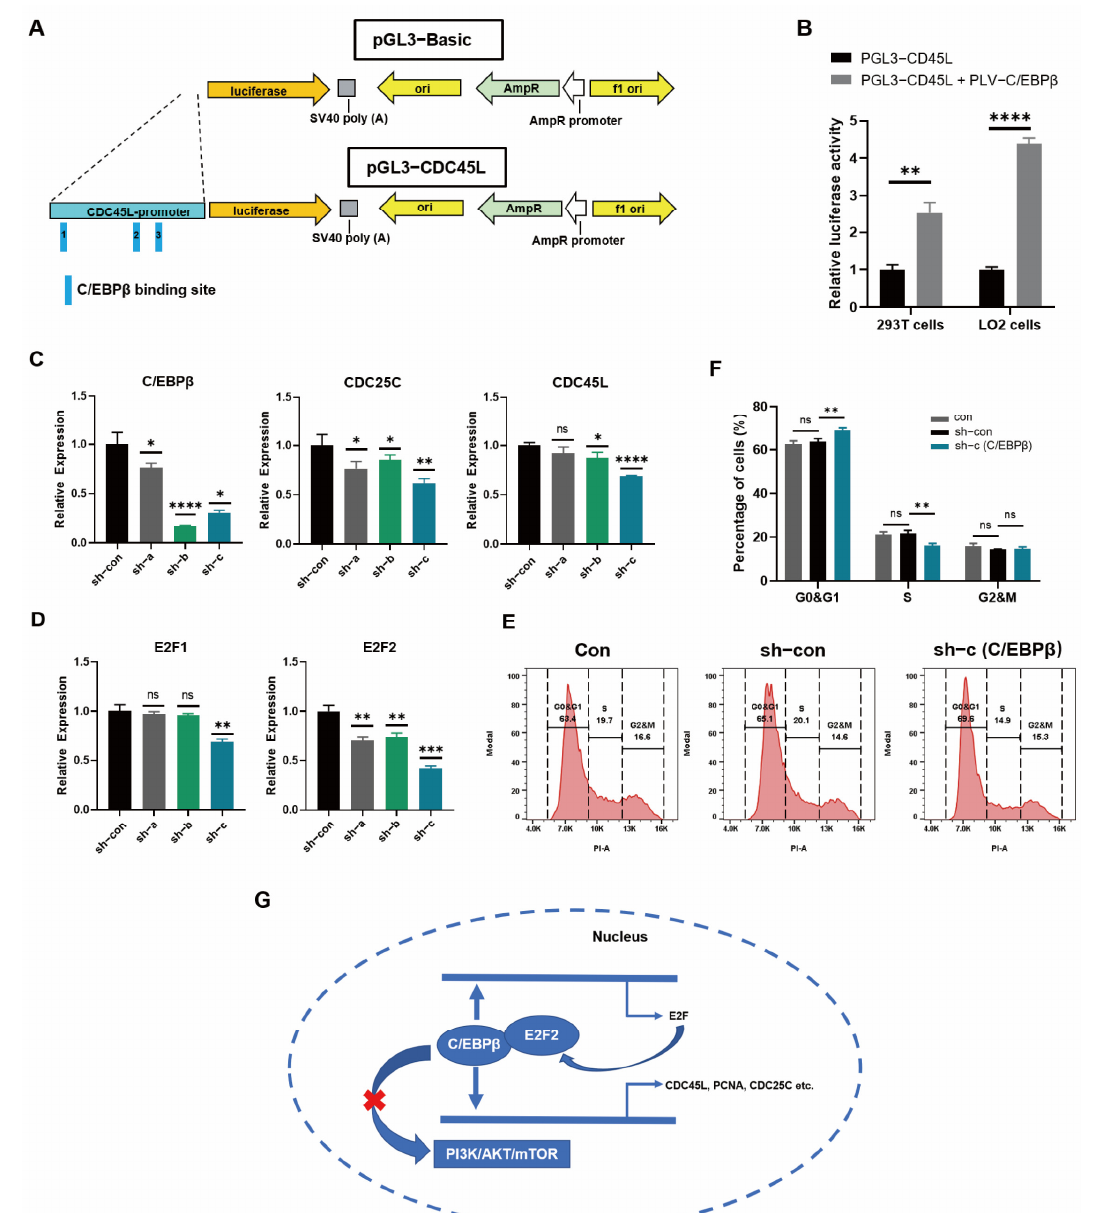
Figure 7. Cell-cycle progression was promoted by C/EBPβ in LO2 cells. ( A ) The schematic diagram shows that C/EBPβ binds to CDC45L promoter regions to regulate luciferase expression. ( B ) Luciferase assays were carried out to verify the C/EBPβ binding activity at promoter regions of CDC45L gene in 293T cells and LO2 cells. ( C , D ) Lentivirus-mediated C/EBPβ knockdown with three pairs of sh-RNA (sh-a, sh-b, and sh-c) was performed to determine the expression of cell-cycle genes ( C ) and transcriptional factor E2Fs genes ( D ) by qRT-PCR assays. ( E , F ) Flow cytometry was performed to detect the proportion of cell-cycle phases after the treatment with sh-RNA (C/EBPβ) in LO2 cells ( E ), and the statistical results of proportion were depicted ( F ) by GraphPad Prism 8 software. ( G ) C/EBP β coupled with E2F2 regulated cell-cycle gene expression in hepatic progenitor cells. C/EBP β first bound to the regulatory region of cell-cycle-regulating transcription factor E2F2 to activate E2F2, then C/EBP β coupled with E2F2 to promote the expression of cell-cycle genes (CDC45L, CDC25C, and PCNA) in hepatic progenitor cells. Data represent mean ± SEM with p -values indicated when significant. p < 0.05 *, p < 0.01 **, p < 0.001 ***, p < 0.0001 ****, ns, not significant. Data are the three samples per